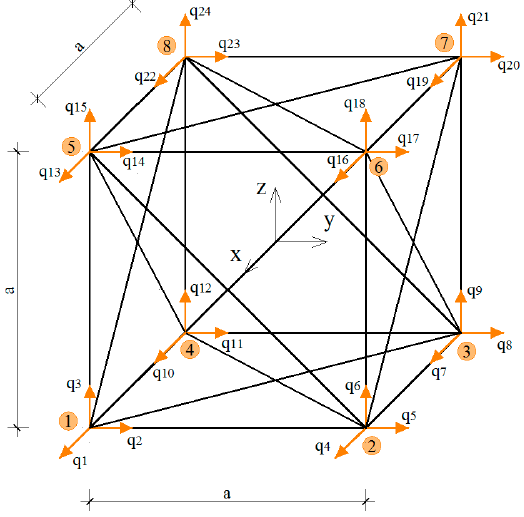
Figure A1. Space truss with 8 nodes and 24 degrees ‐ of ‐ freedom.